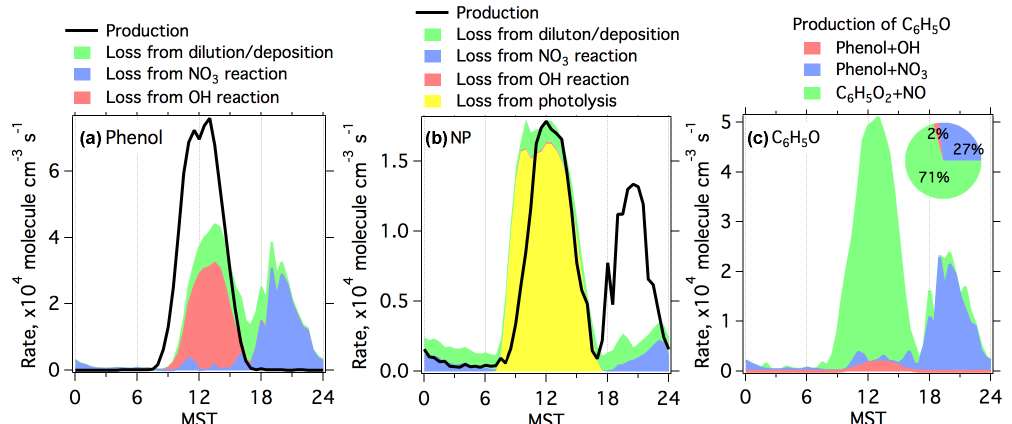
Figure 7. Diurnal profiles of production and loss rates from different pathways for phenol (a) and NP (b) derived from the base simulation of the box model. (c) Diurnal profiles of production rates from different pathways for C 6 H 5 O radicals. The inserted pie chart in (c) shows contributions from three different pathways to formation of C 6 H 5 O radicals on a daily basis.